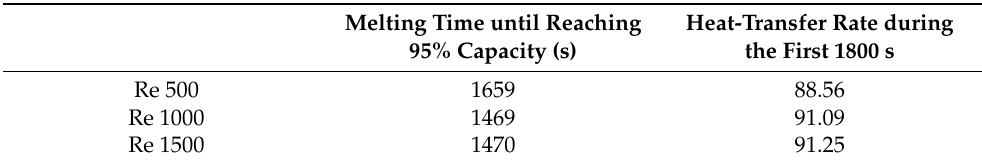
Table 3. Melting time until achieving 95% and the heat-transfer rate in 1800 s for the cases of Re equals 500, 1000, and 1500.